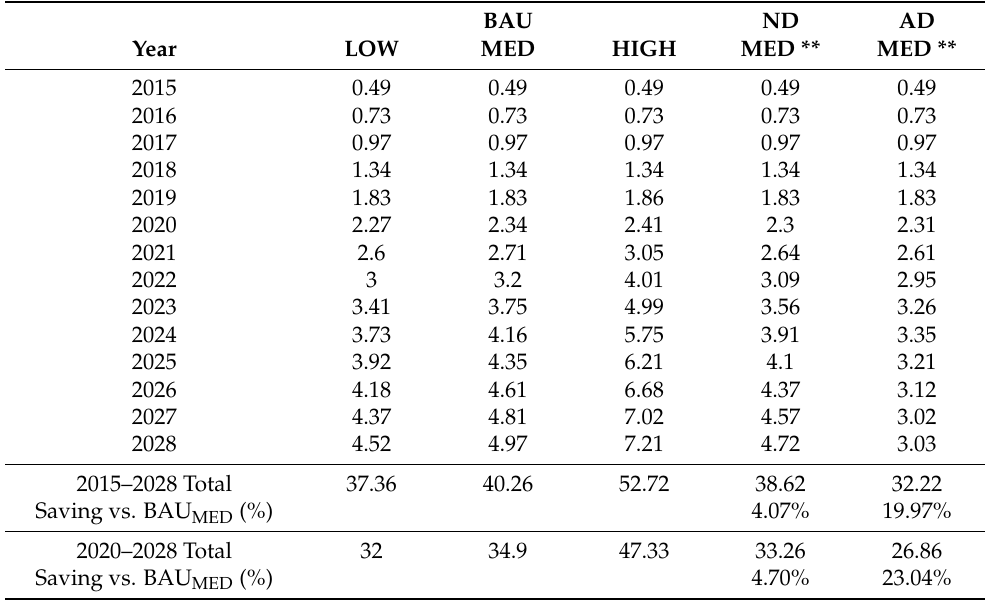
Table 5. Estimated data centre CO 2